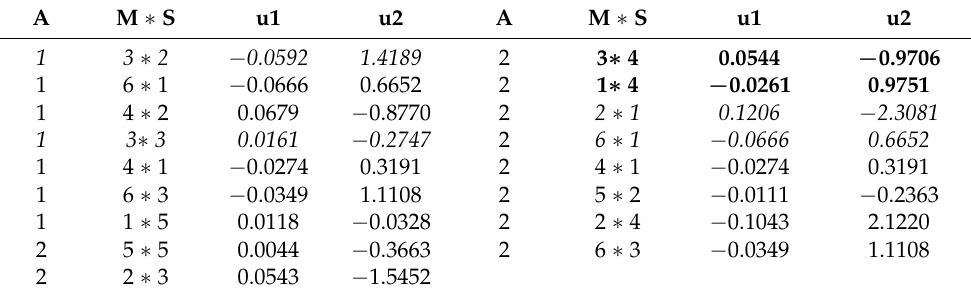
Table 8. Estimated values of the random effects.